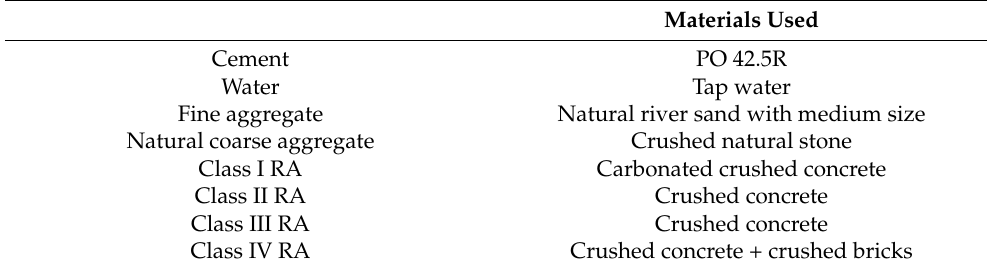
Table 3. Materials used in the laboratory